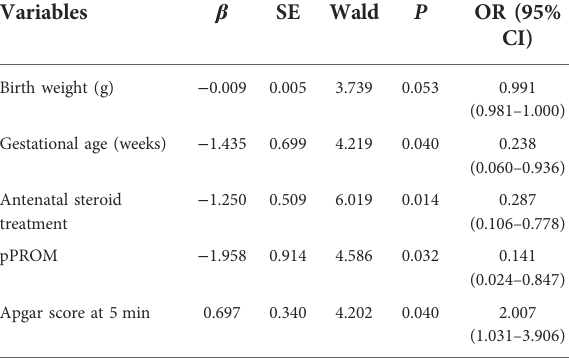
TABLE 3 Multivariate logistic regression of independent risk factors of